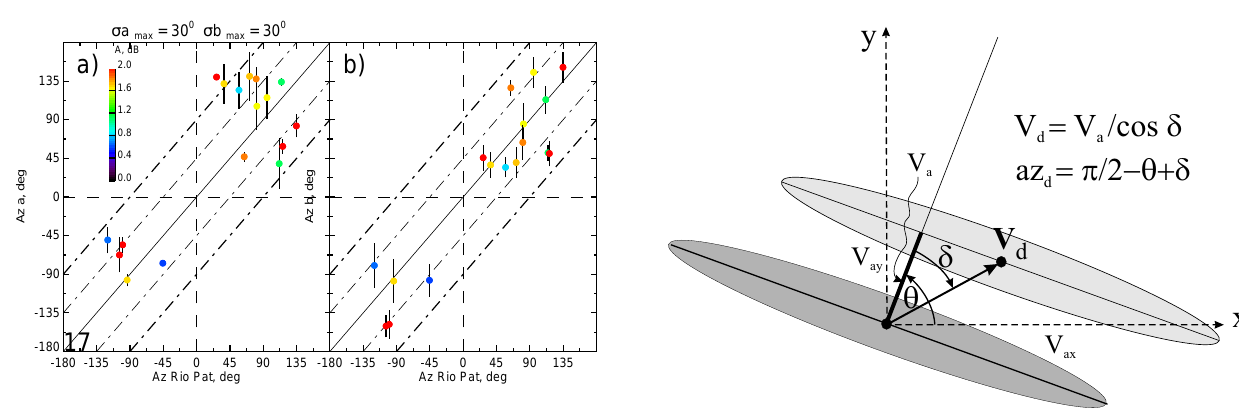
Fig. 10. Motion of elongated absorption patch. The initial (final) patch position is shown by the dark (light) ellipse. The velocity of apparent motion (perpendicular to the longest patch dimension) V a is obtained from the apparent velocities along the axes V ax and V ay